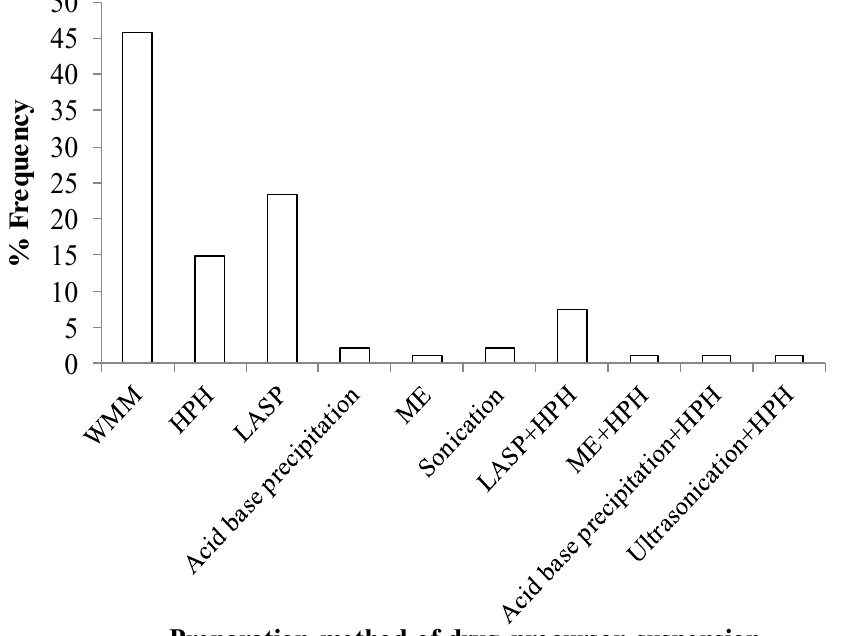
Figure 4. The usage frequency of various drug nanosuspension preparation methods in the studies reported in Table 2. The sample size for the analysis here is 94, even though the number of publications in Table 2 is 92, because two studies compared two different preparation methods.